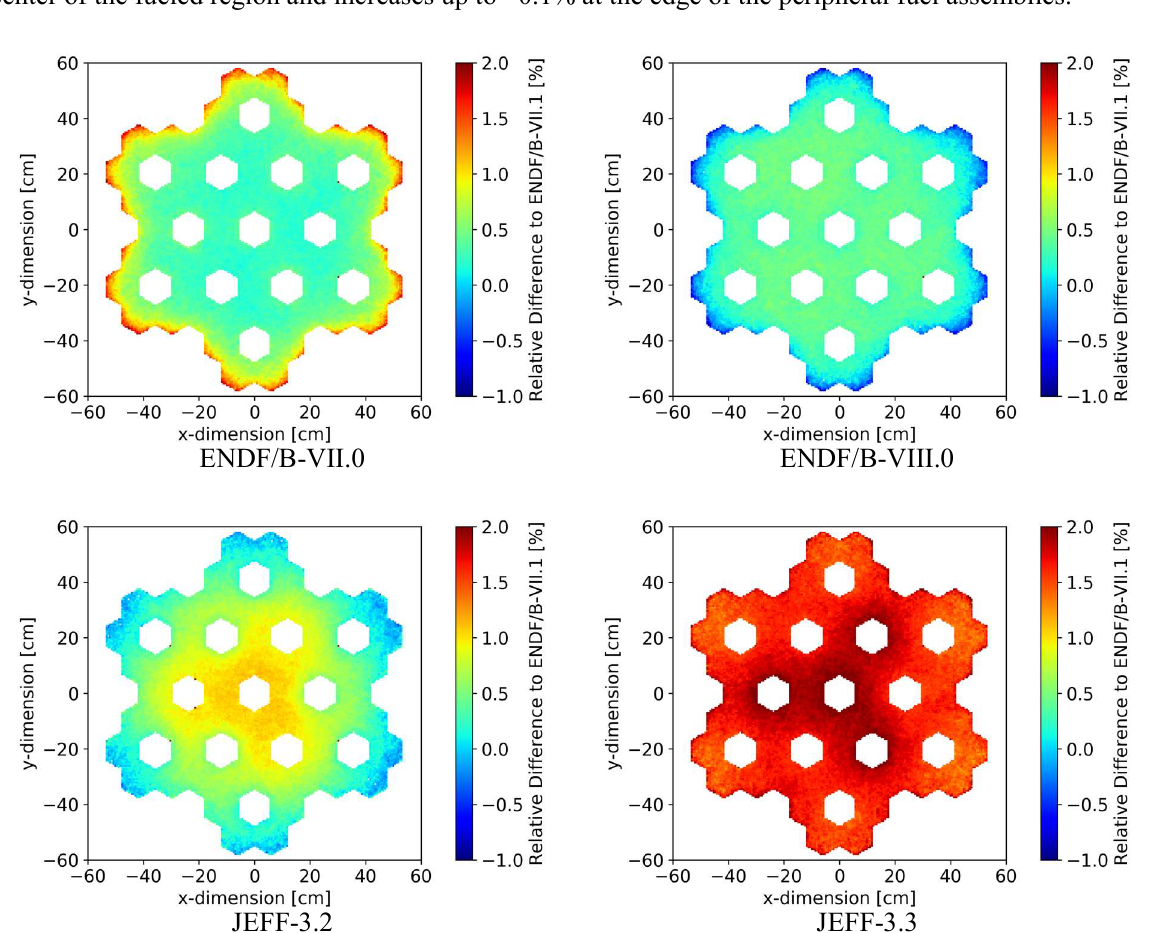
Figure 5. Fission Rate Relative Differences from Reference ENDF/B-VII.1